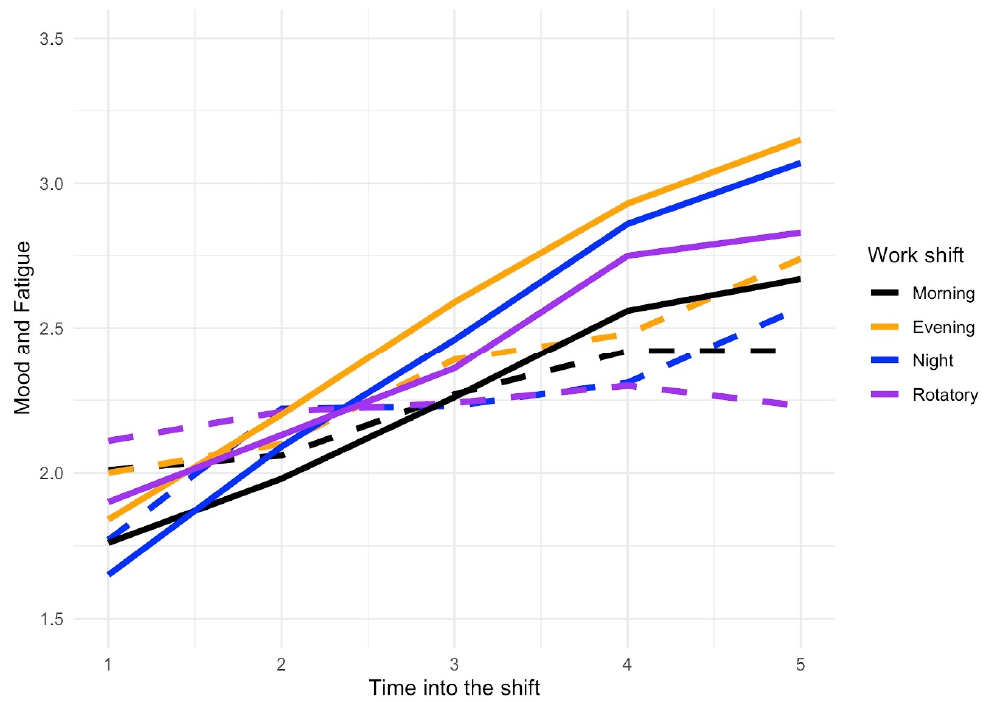
Figure 2. Evolution of mood and fatigue during the shift: Continuous lines represent mood and dashed lines represent fatigue. The higher values reflect negative mood and high fatigue. The range 1–5 of the dependent variables is limited to 1.5–3.5 for better visualization.